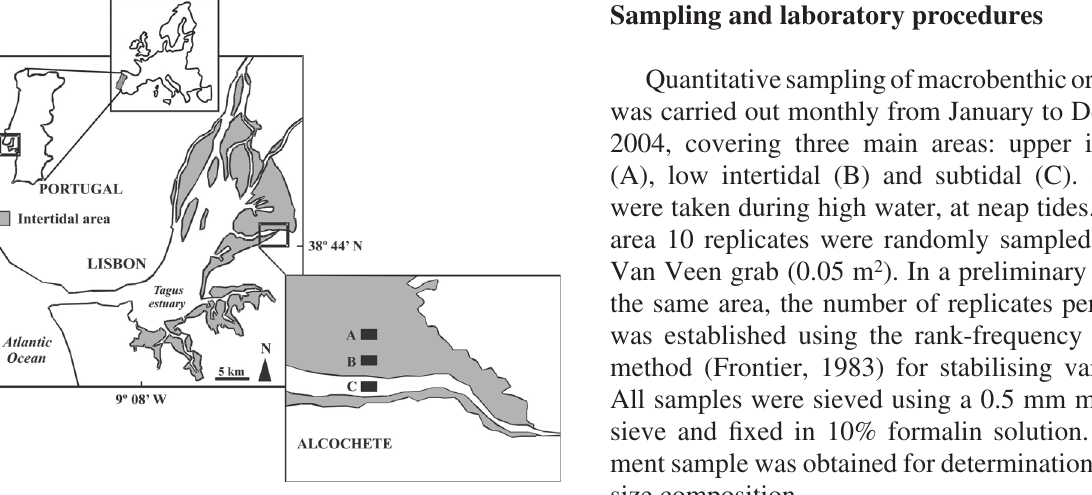
Fig . 1. – location of sampling areas in the tagus estuary: a, upper intertidal; b, lower intertidal; C,